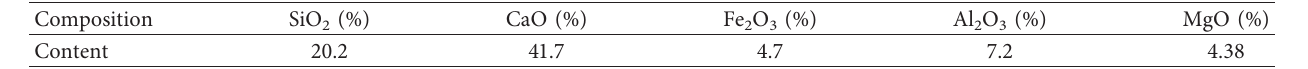
Table 1: Chemical composition of cement.